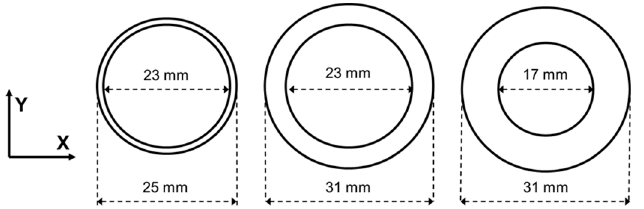
Figure 2. Sketch showing different cross-section diameters of cylinders designed according to post-AM treatment.